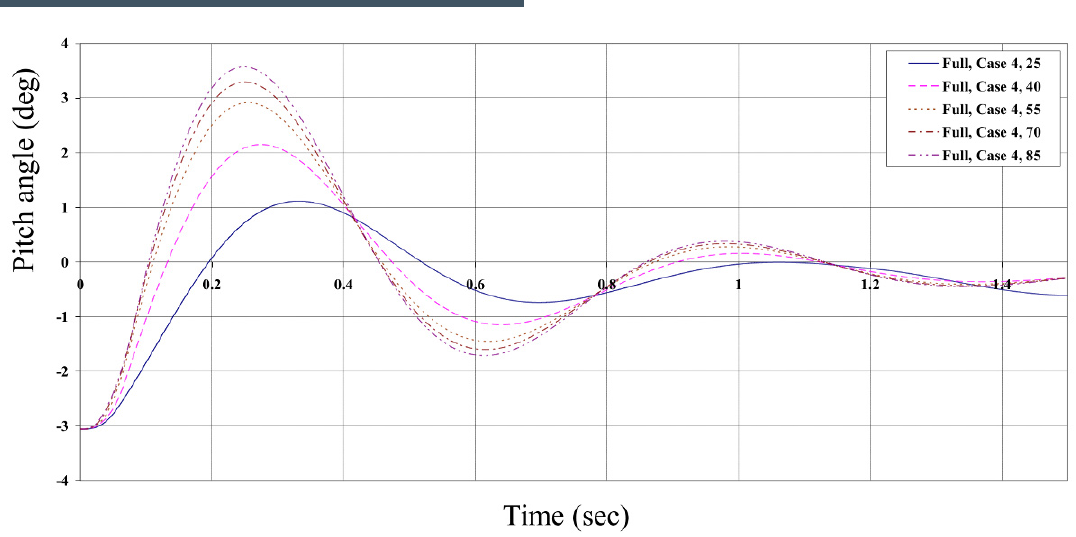
Figure 24. Pitch angle of the vehicle body at the different five speeds with case 4.